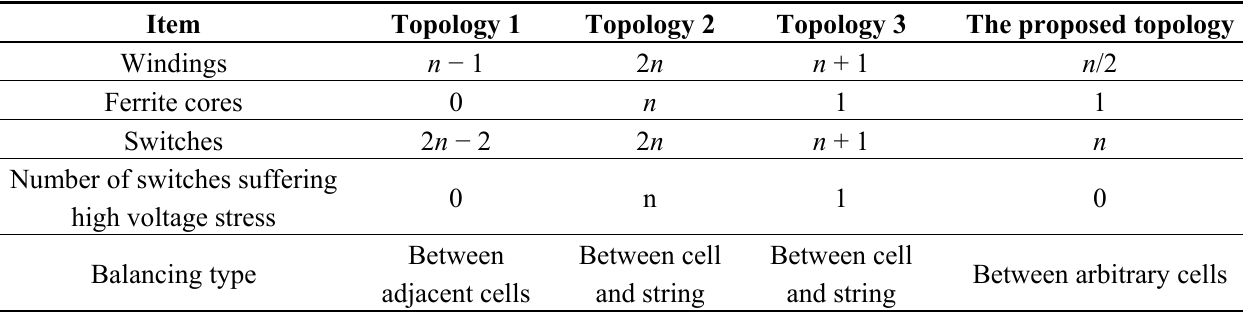
Table 1. A comparison of component